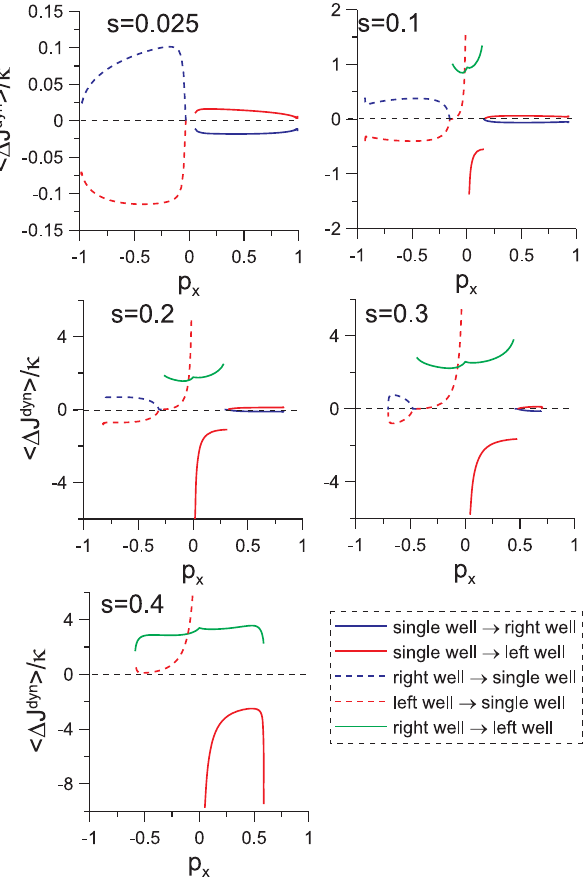
Fig. A3. Dynamical jumps in the system with various s without terms ∼ { S l ,S r }